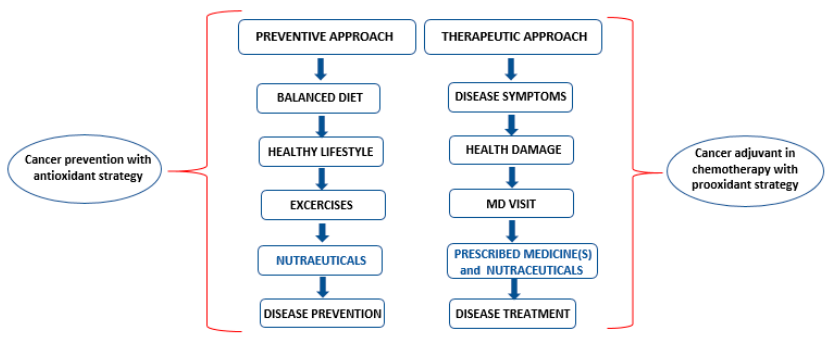
16 of 25 Figure 3. Antioxidant treatment versus pro-oxidant treatment during chemotherapy. 6. Conclusions A lot of patients, after cancer diagnosis, turn to nutraceuticals in the belief that this dietary supplementation could have good benefits. Certain plant-based supplements may antagonize and alter the metabolism of therapeutic agents, influencing their effectiveness. Some natural compounds,